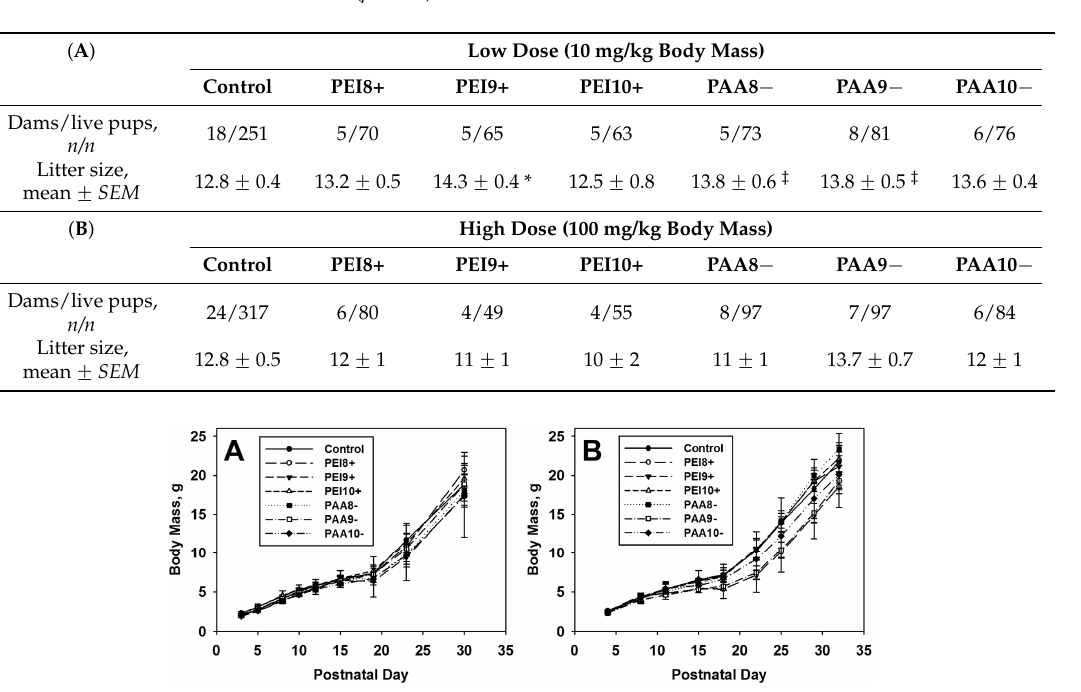
Figure 2. Growth charts of mice exposed to 10 mg/kg ( A ) or 100 mg/kg ( B ) of iron oxide NPs in utero on various days of gestation (GD 8, 9, or 10). Calculations include values from cesarean evaluations and dams that littered.